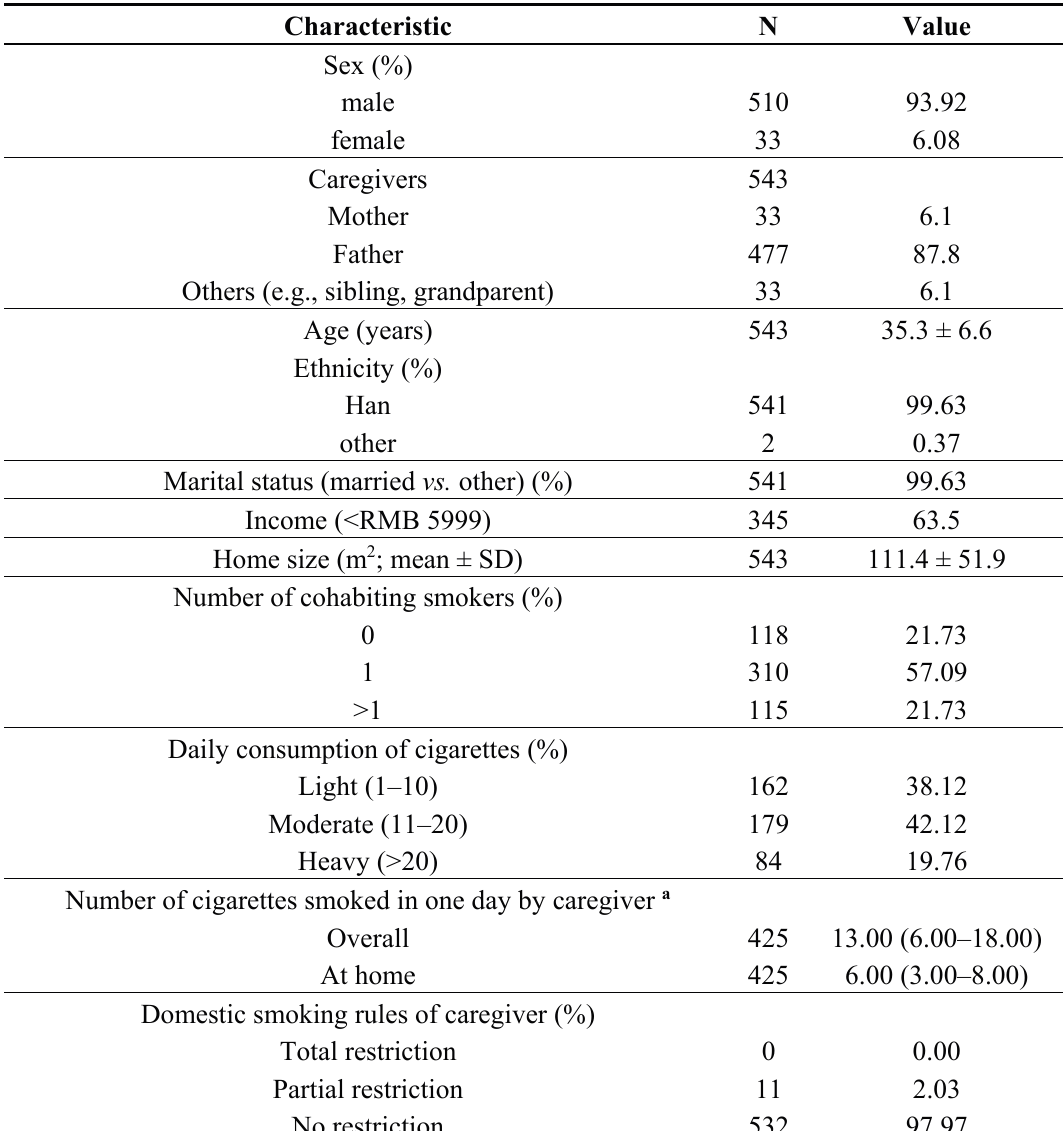
Table 1. Characteristics of